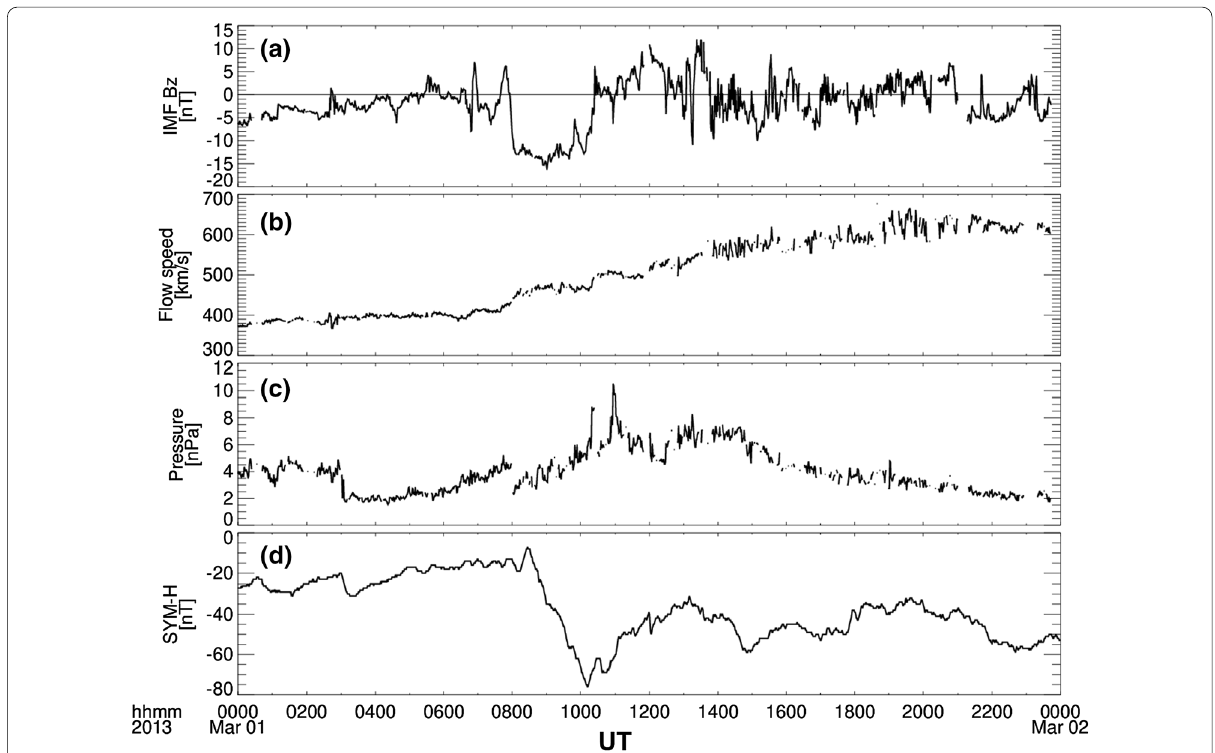
Fig. 1 Time-series plots of a IMF Bz, b solar wind velocity, c solar wind dynamic pressure, and d SYM-H index on March 1,